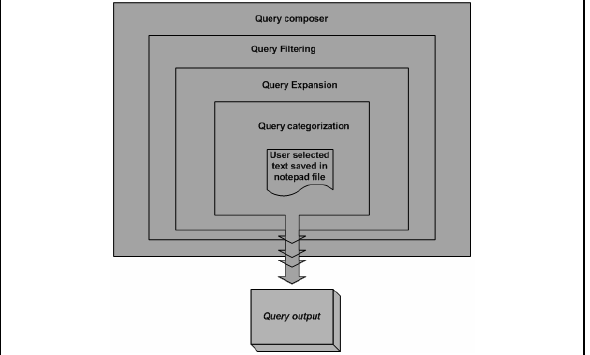
Figure 3: Search Query Generation Strategy